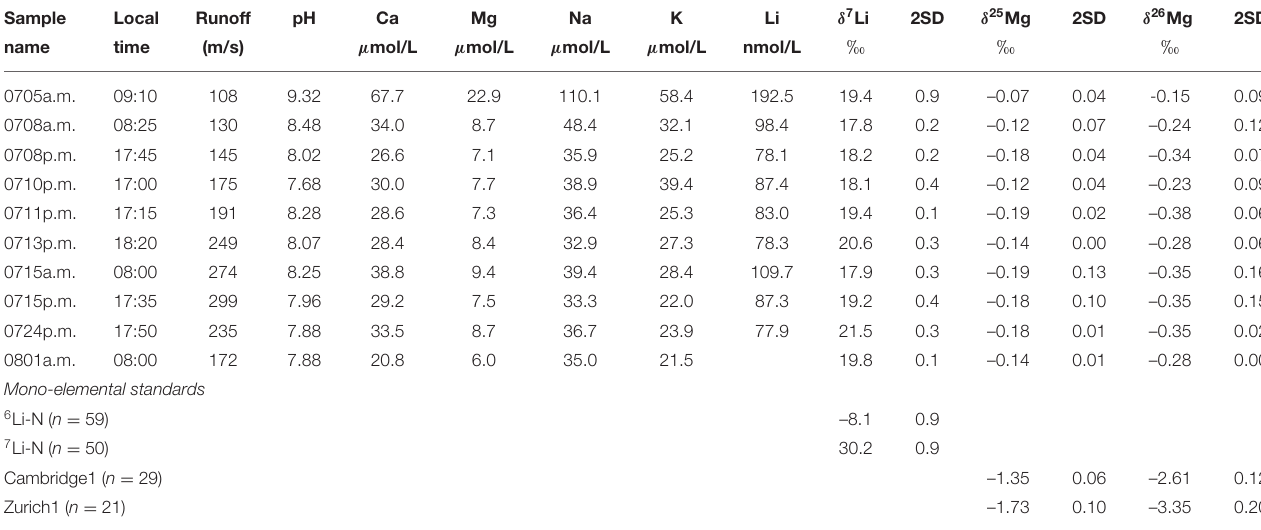
TABLE 2 | Major cation (Hindshaw et al., 2014) and isotopic composition of Leverett River water samples in 2009.